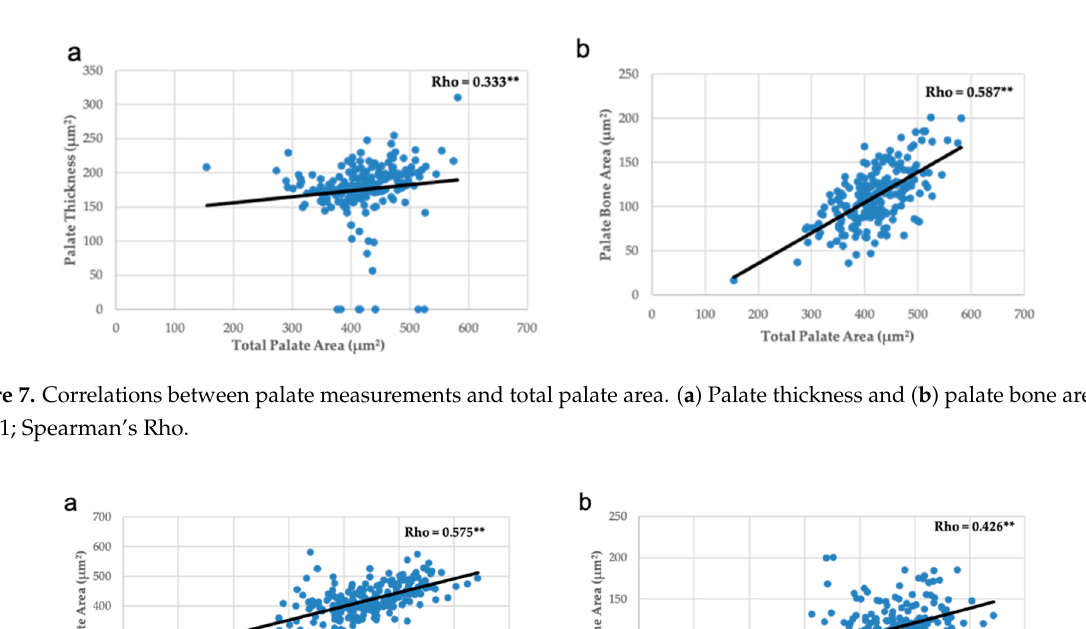
Figure 6. Correlations between palate measurements with weeks on maternal FAD diet. ( a ) Palate thickness; ( b ) right half palate area; ( c ) left half palate area; ( d ) total palate area and ( e ) palate bone area. * p ≤ 0.05; ** p ≤ 0.01.